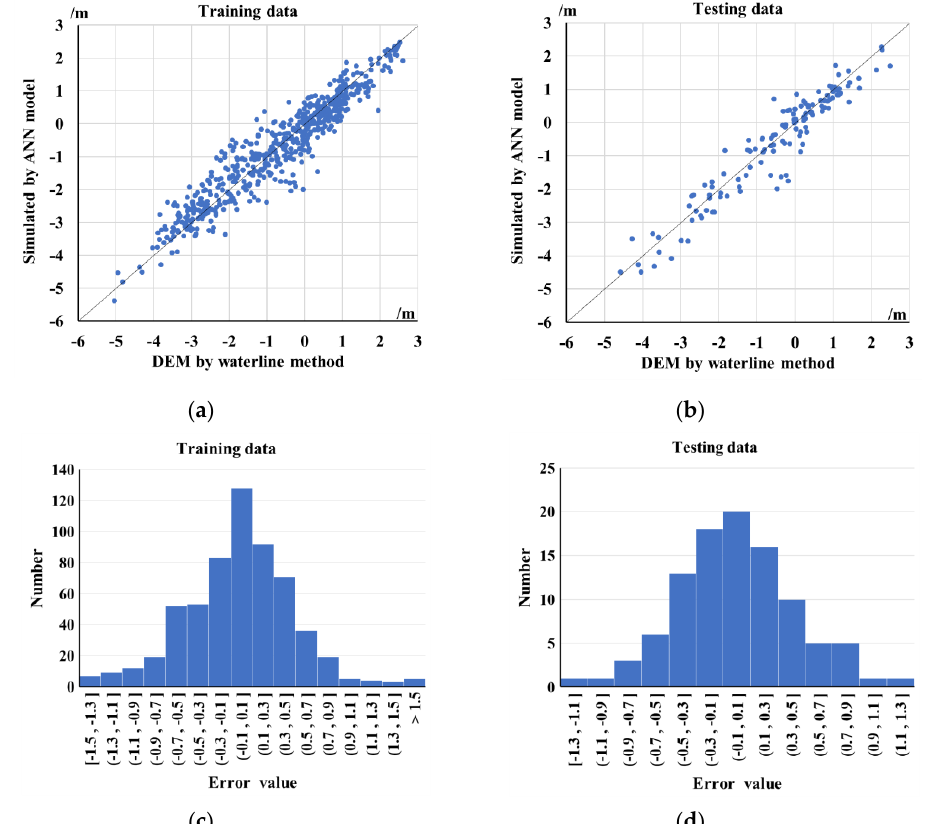
Figure 7. ANN model assessment maps: ( a ) Comparative map of training data; ( b ) comparative map of testing data; ( c ) error histogram of training data; ( d ) error histogram of testing data.